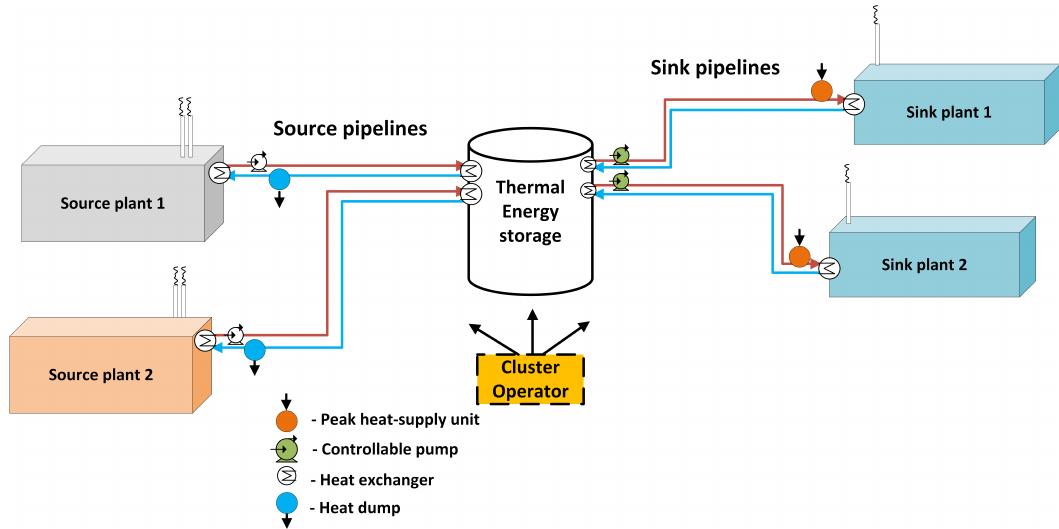
Figure 3. Illustration of industry cluster case study with two source plants with surplus heat and two sink plants with heat demands. The surplus-heat exchange involves intermediate thermal storage controlled by a cluster